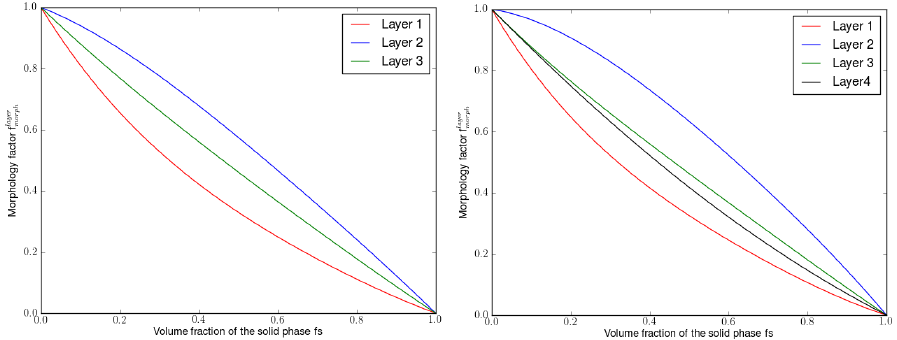
Figure 2. Morphology factors as a function of the volume fraction of the solid phase (layer 1 corresponds to the layer near the solid core of the particle and layer 3 to the layer near the interface) for three diffusion layers (left) and four diffusion layers